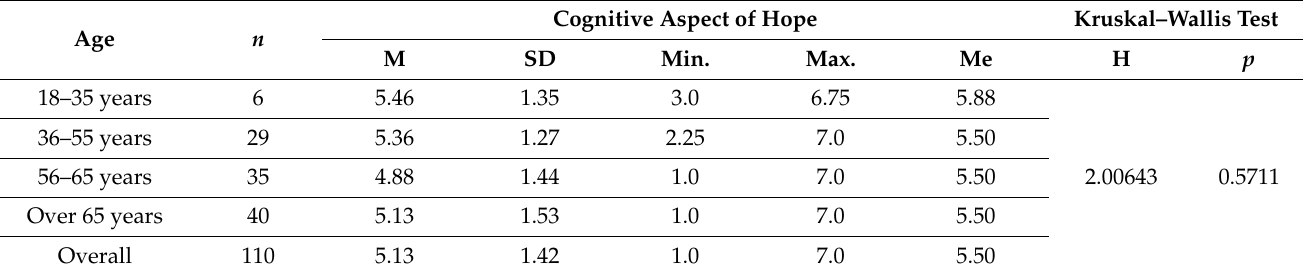
Table 8. Perception of hope in the cognitive aspect depending on the age of the surveyed men—measured via the DSN-3